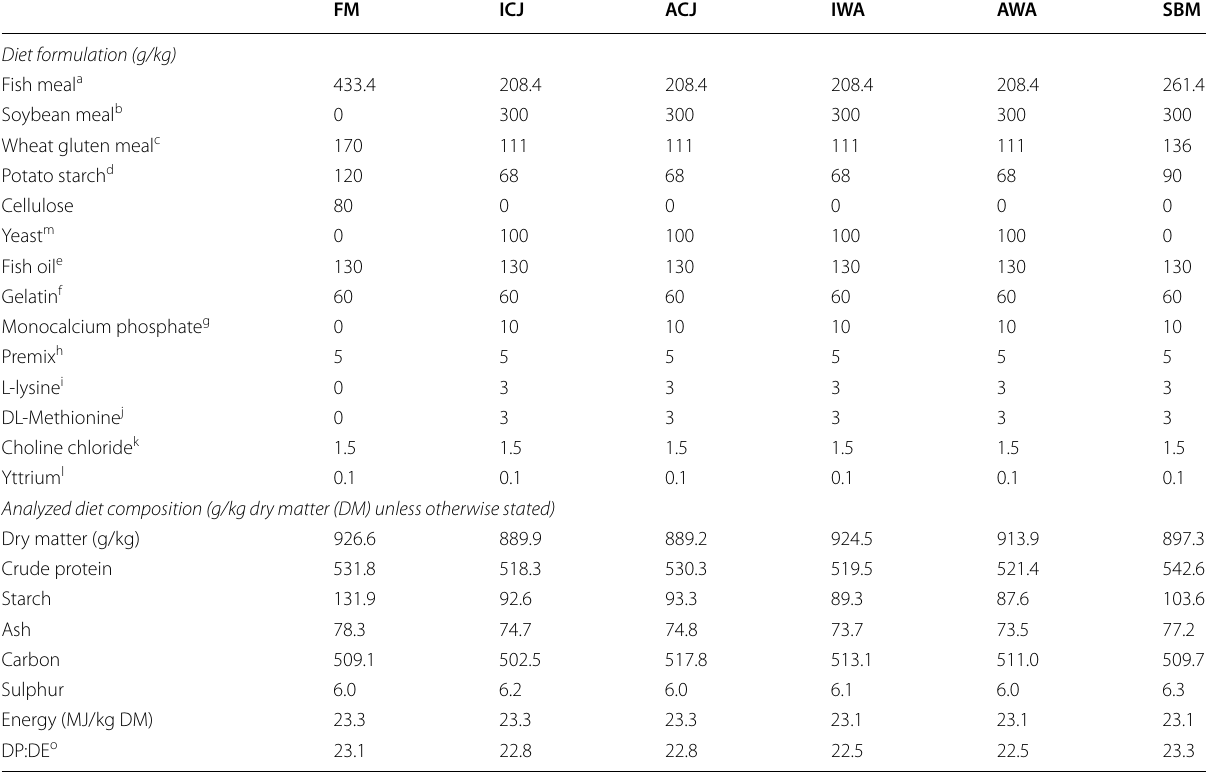
a LT fishmeal, Norsildmel, Egersund, Norway; b Soybean meal, Denofa AS, Fredrikstad, Norway; c Wheat gluten, Amilina AB, Panevezys, Lithuania; d Lygel F 60, Lyckeby Culinar, Fjälkinge, Sweden; e NorSalmOil, Norsildmel, Egersund, Norway; f Rousselot 250 PS, Rousselot SAS, Courbevoie, France; g Monocalcium phosphate, Bolifor MCP-F, Oslo, Norway Yara; h Premix fish, Norsk Mineralnæring AS, Hønefoss, Norway. Per kg feed; Retinol 3150.0 IU, Cholecalciferol 1890.0 IU, α-tocopherol SD 250 mg, Menadione 12.6 mg, Thiamin 18.9 mg, Riboflavin 31.5 mg, d-Ca-Pantothenate 37.8 mg, Niacin 94.5 mg, Biotin 0.315 mg, Cyanocobalamin 0.025 mg, Folic acid 6.3